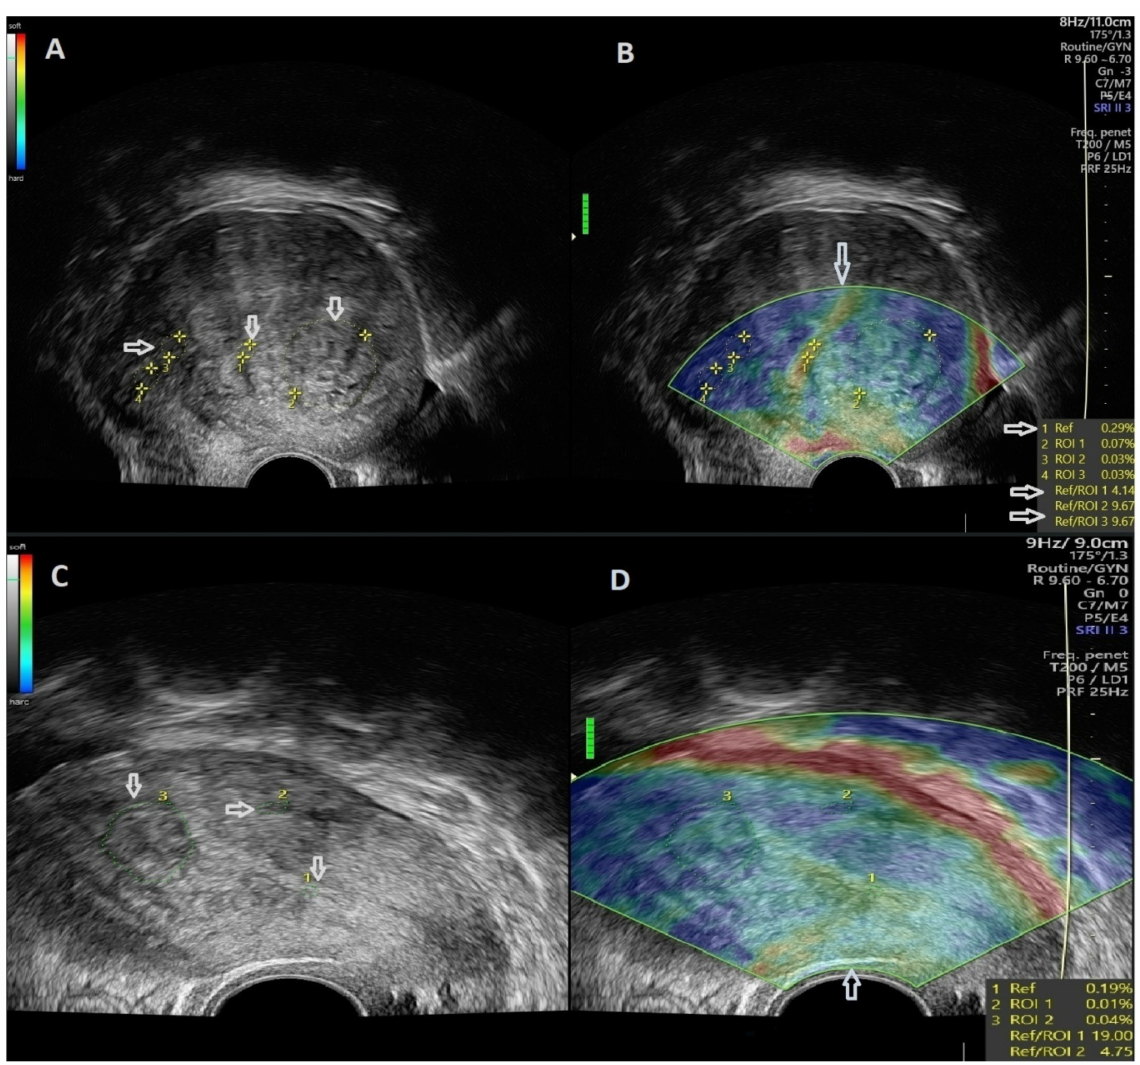
Figure 3. ( A ) Arrows depict ROI placement for comparative assessment of healthy, referral tissue with adenomyotic lesions (left side of the image) and a uterine fibroid (right side of the image). ( B ) SRE evaluation of an image acquired through dual-mode, real-time TVUS illustrating a uterine fibroid and adenomyosis. ( C ) Arrows depict ROI placement for comparative assessment of healthy, referral tissue and adenomyotic with adenomyotic lesions (superior part of the image) and uterine fibroid tissue (inferior part of the image). ( D ) SRE evaluation of an image acquired through dual-mode, real-time TVUS illustrating a uterine fibroid and